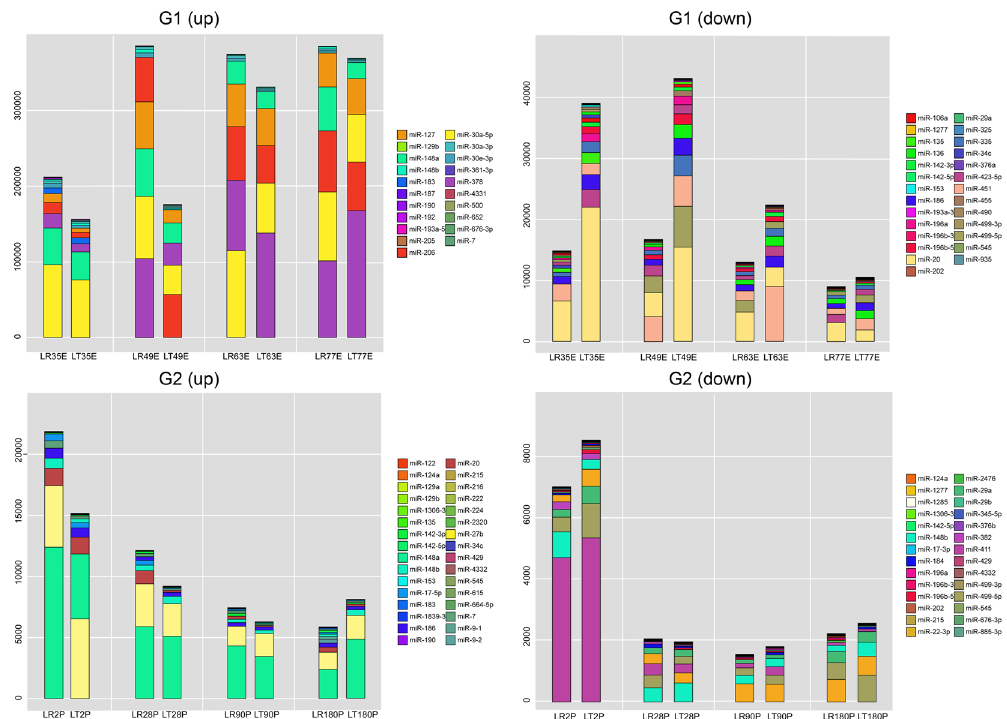
Figure 3. Summary of the most abundant up- and down-regulated miRNAs between breeds. ( A ) most abundant up-regulated miRNAs in G1; ( B ) most abundant down-regulated miRNAs in G1; ( C ) most abundant up-regulated miRNAs in G2; and ( D ) most abundant down-regulated miRNAs in G2. Both breeds are depicted in ( A – D ). Different colors representing different miRNAs are listed on the